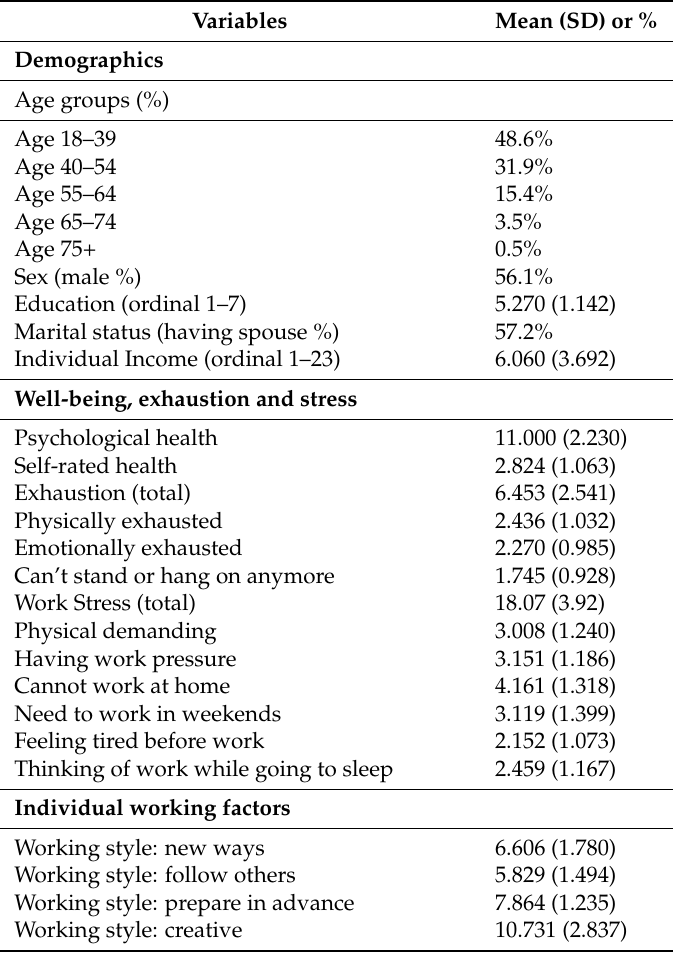
Table 1. Description of the sample ( n =